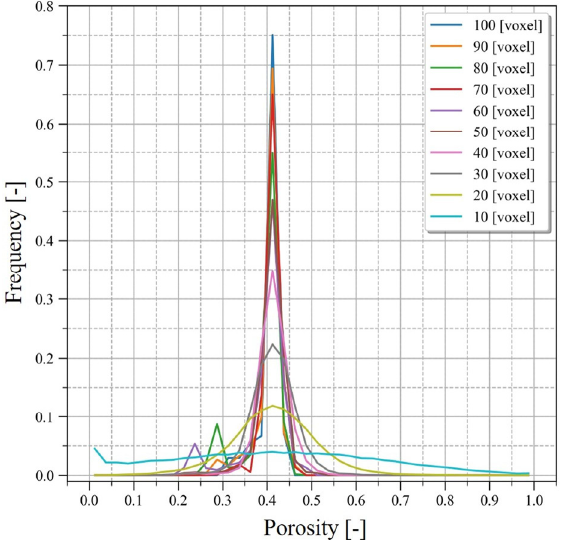
Figure 10. Histogram of the porosity. The porosity was calculated as the grid size of the representative volume element every 10 voxels between 10 and 100 voxels for S0.